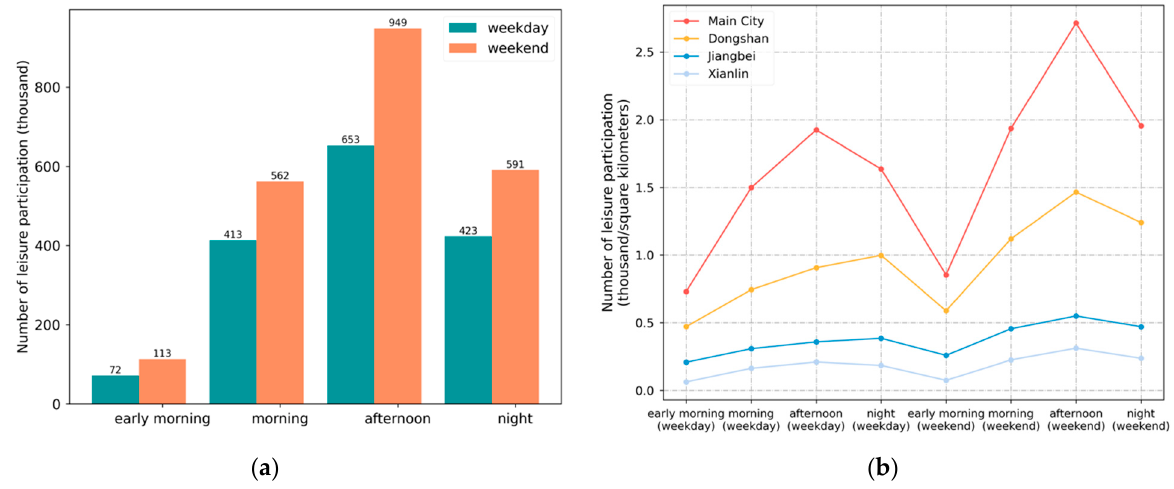
Figure 5. The statistical distribution of the number of urban leisure on weekdays and weekends: ( a ) Shows the hull number of leisure groups; ( b ) shows the leisure density (number of leisure activities per km 2 ) in different districts.